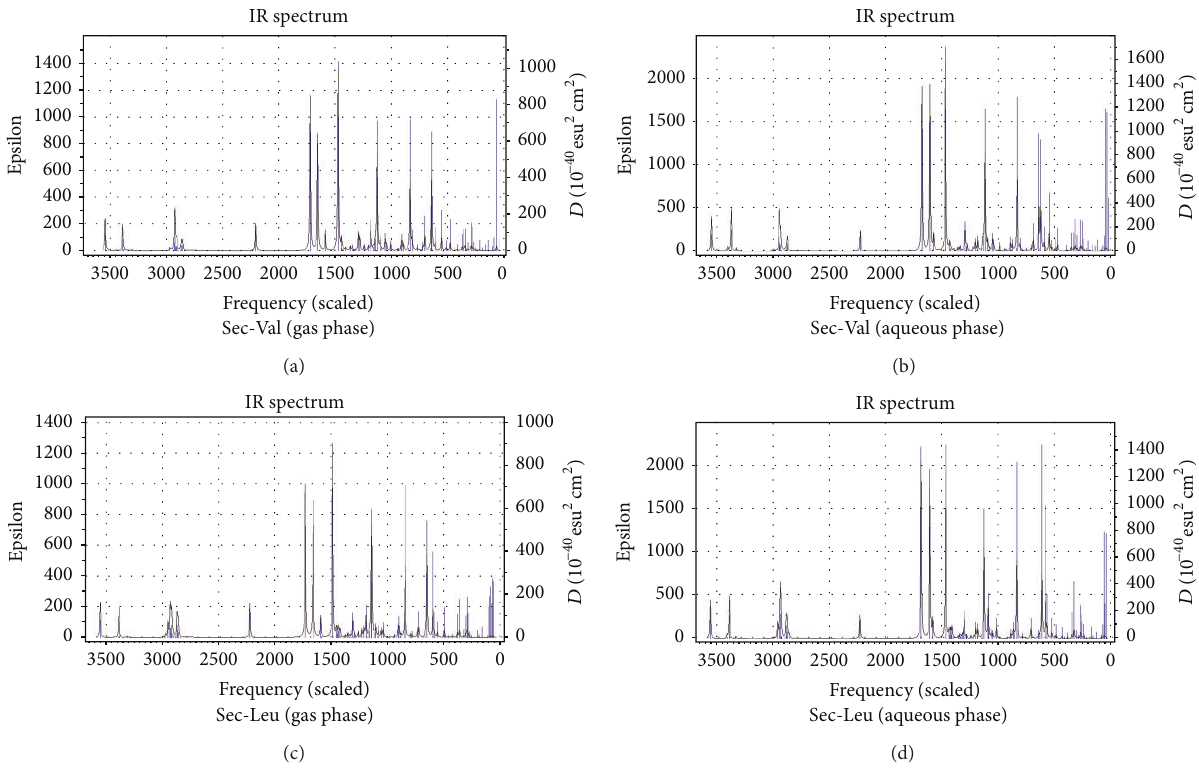
Figure 4: Vibrational spectra of Sec-Val and Sec-Leu in gas and aqueous